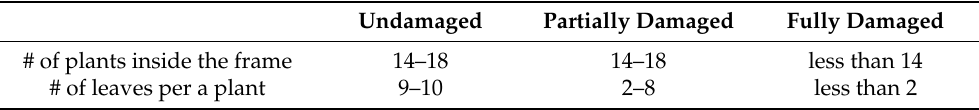
Table 1. The number of rapeseed plants and their leaves per image for classification task.